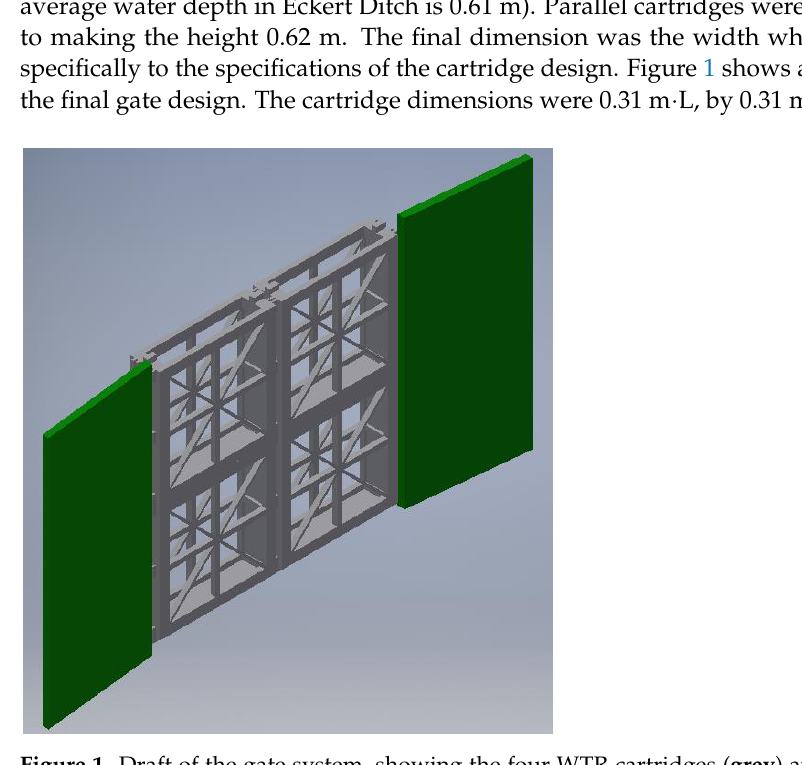
Figure 1. Draft of the gate system, showing the four WTR cartridges ( grey ) and the sloped walls ( green ). Image made using AutoDesk Inventor Professional, San Rafael, CA, USA 2019.